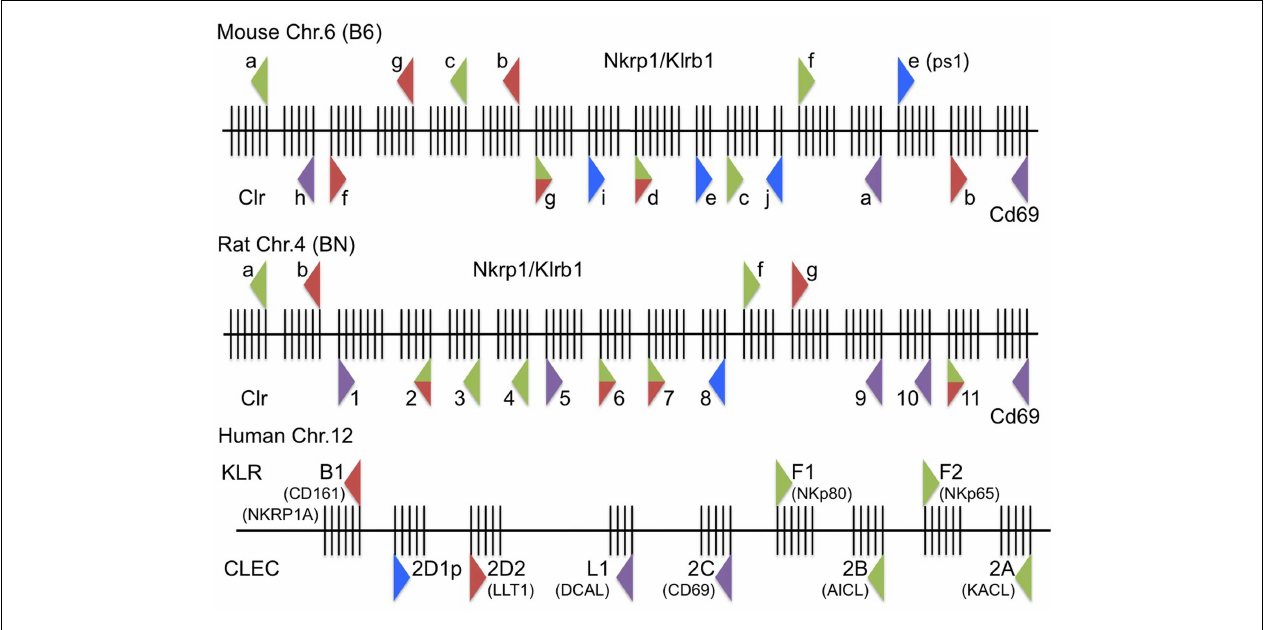
structure (vertical exon lines); triangle representations are as in Figure 1 . (Middle)The rat Nkrp1/ Klrb1 receptor genes and Clr/ Clec2 ligand genes on rat chromosome 4 (BN-strain reference sequence, genome build: November 2004, Baylor 3.4/rn4) are depicted as above. (Bottom)The human KLRB/F receptor genes and CLEC ligand genes on human chromosome 12 (genome build: February 2009, GRCh37/hg19) are depicted as above. Not to